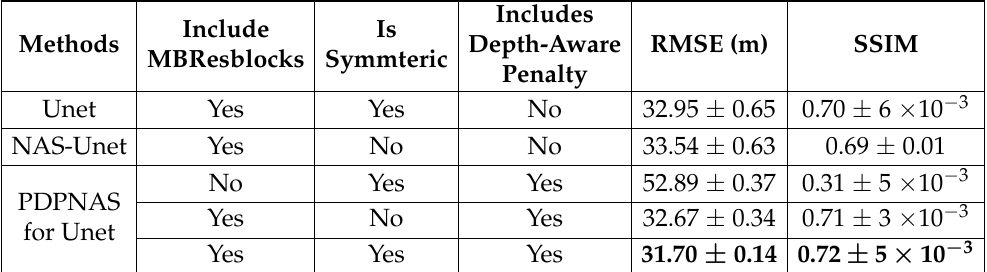
Figure 11. RMSE and SSIM of Unet with I + SH and I + SH + d and PDPNAS for Unet with I + SH + d on Guiyang datasets. x-axis represents the downsampling ratios (or the percentages of sampled points) of SH . ( a ) The RMSE results. ( b ) The SSIM results. Table 4. Comparison experiments on the effect of PDPNAS for Unet in Guiyang datasets. The down- sampling factors of sparse height information are 96 ×